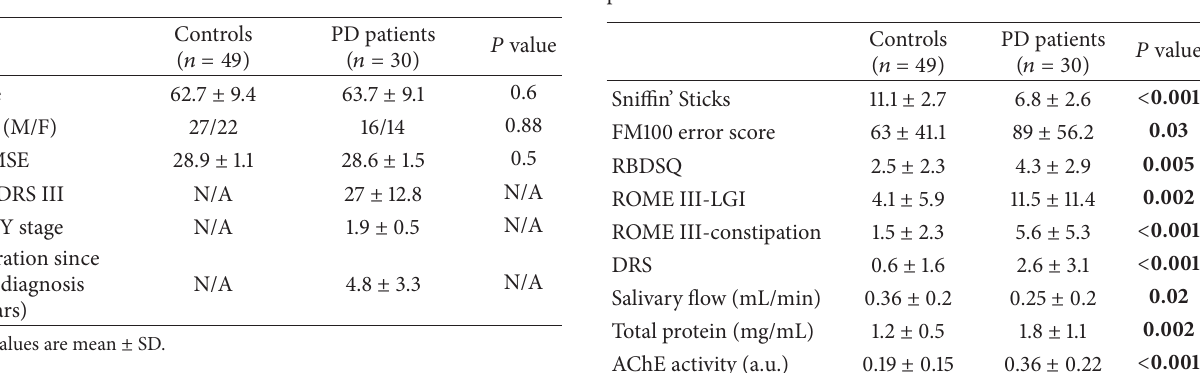
Table 2: Comparison of clinical and biochemical parameters in patients and